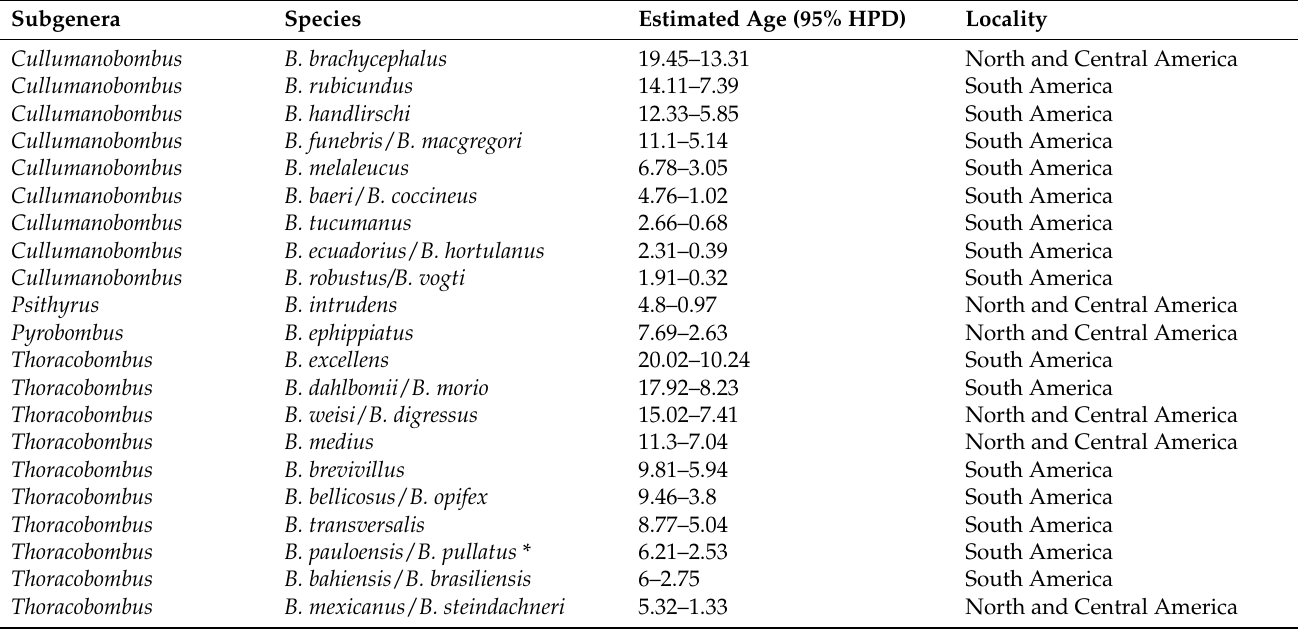
Table 2. Dates of diversification for the Neotropical species of Bombus . Tree with the maximum clade credibilities and branch lengths equal to the median ages as calculated from 75,001 post